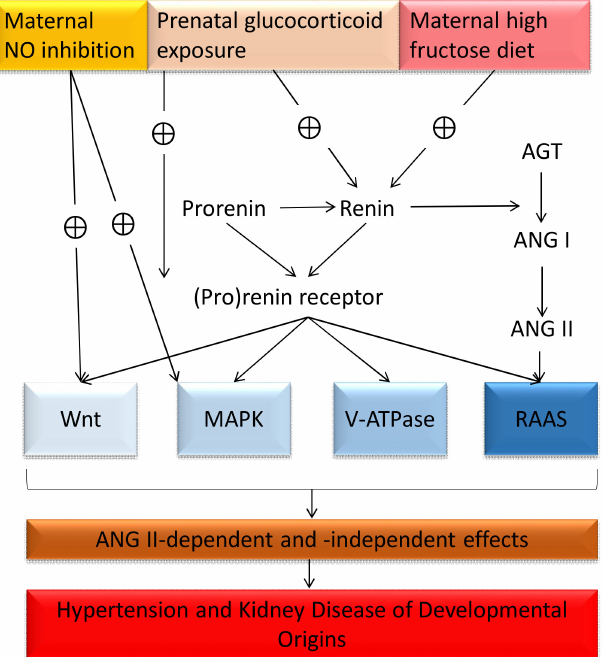
Figure 2. Flow diagram of identified pathways from previous models of renal programming, whereby (pro)renin–PRR pathway is linked to programmed hypertension and kidney disease via ANG II-dependent and –independent effects. AGT, angiotensinogen; ANG I, angiotensin I; ANG II, angiotensin II; MAPK, mitogen-activated protein kinases; NO, nitric oxide; RAAS, renin-angiotensin- aldosterone system, ⊕ ,